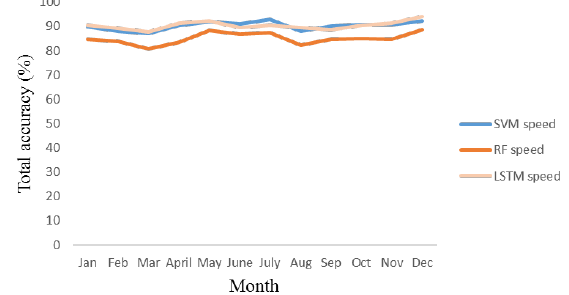
Figure 4: Total accuracy for different months for Netherlands (in speed case).